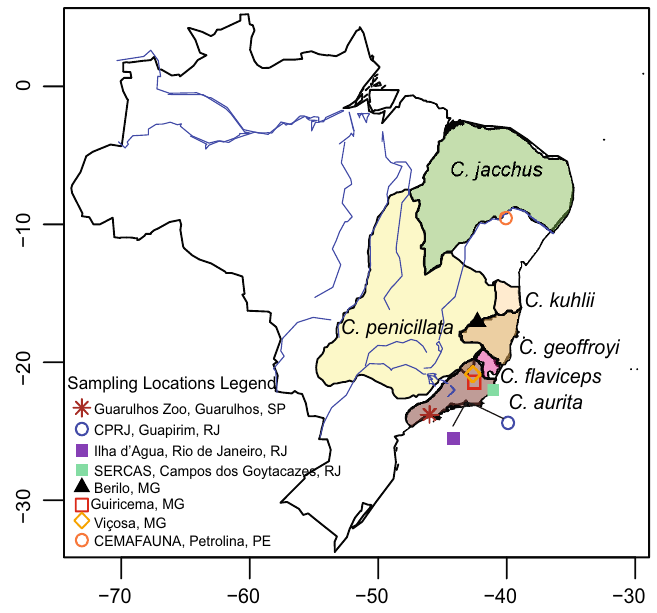
Figure 1. Natural Callithrix ranges and sampling locations in Brazil. Sampling locations are represented by different colored shapes and species names are written next to their respective ranges. Ranges are based on 2012 IUCN Red List Spatial Data from http:// www. iucnr edlist. org/ techn ical- docum ents/ spati al- datam, and the accompanying map was produced by the authors with the R 4.1.0 scripting language 57 . Legend abbreviations are as follows- MG: Minas Gerais, Rio de Janeiro: RJ, Pernambuco: PE, São Paulo: SP; CPRJ: Centro de Primatologia do Rio de Janeiro; CEMAFAUNA: Centro de Conservação e Manejo da Fauna da